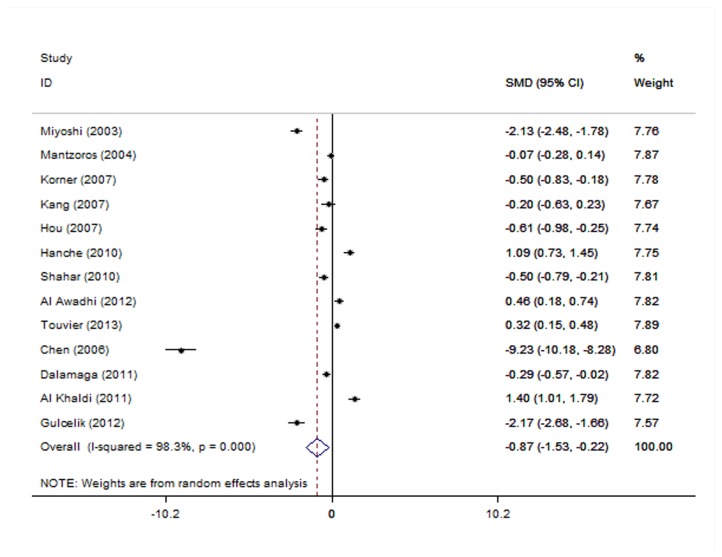
The effect of adiponectin on breast cancer (SMD).